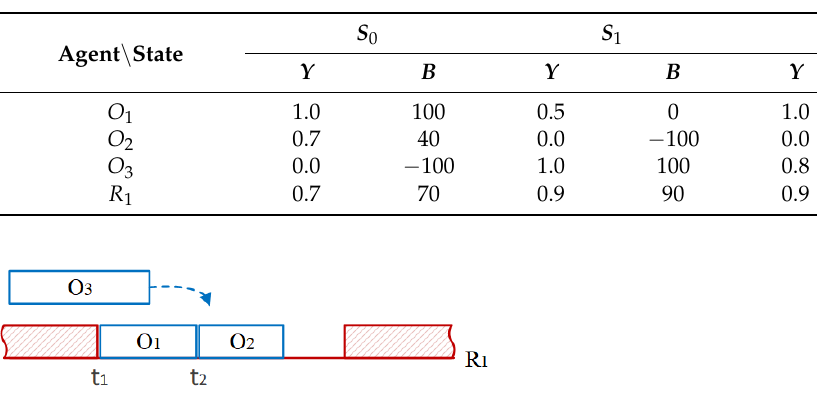
Figure 5. The initial state of orders and resources. Figure 7. The initial state of orders and resources.